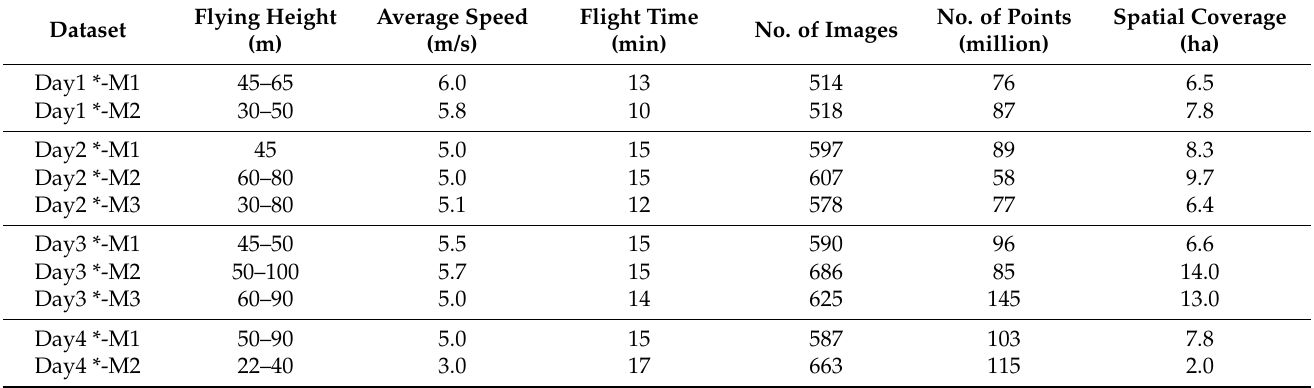
Figure 4. Illustration of a single mission coverage (mission #2 collected on 27 July 2019) along the west coast of Dana Island with the LiDAR colored by RGB data (whenever available)—otherwise, LiDAR data are colored by height. Table 2. Specifications of UAV data acquisitions along the west coast of Dana